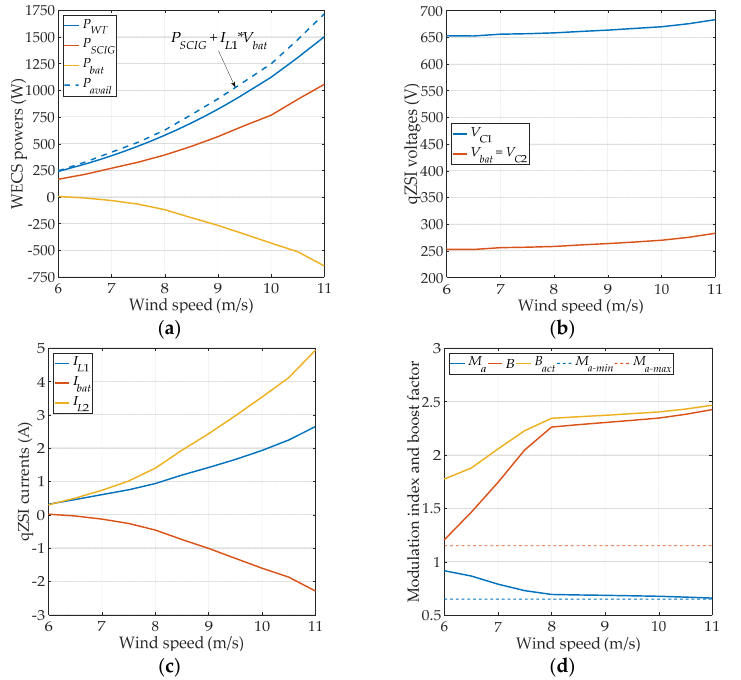
Figure 8. Steady-state characteristics for wind speed variation ( V dc = 400 V, V ac = 230 V): ( a ) WECS powers; ( b ) qZSI voltages; ( c ) qZSI currents; ( d ) modulation index and boost factor.